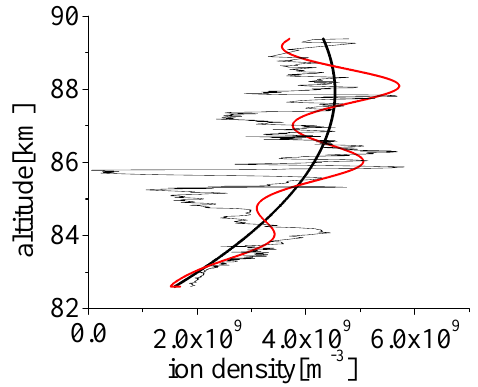
Fig. 6. Gravity wave modulates the ion density distribution (red solid line). The measuring result (black thin line) is also from the Fig.6 Gravity wave modulates the ion density distribution. (red solid line). ECT02 rocket The measuring result (black thin line) is also from the ECT02 rocket data